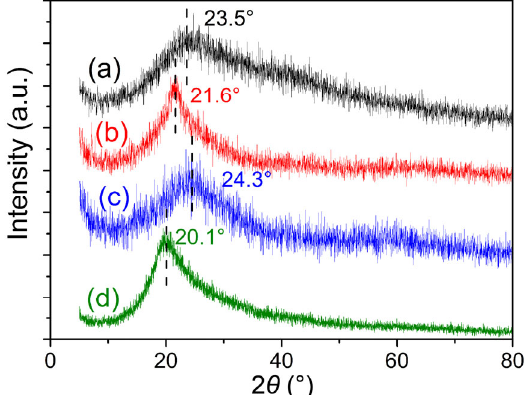
Fig. 3 XRD patterns of (a) CNPs-Na, (b) CNPs-Cl, (c) A-g-CNPs, and (d) C-g-CNPs.